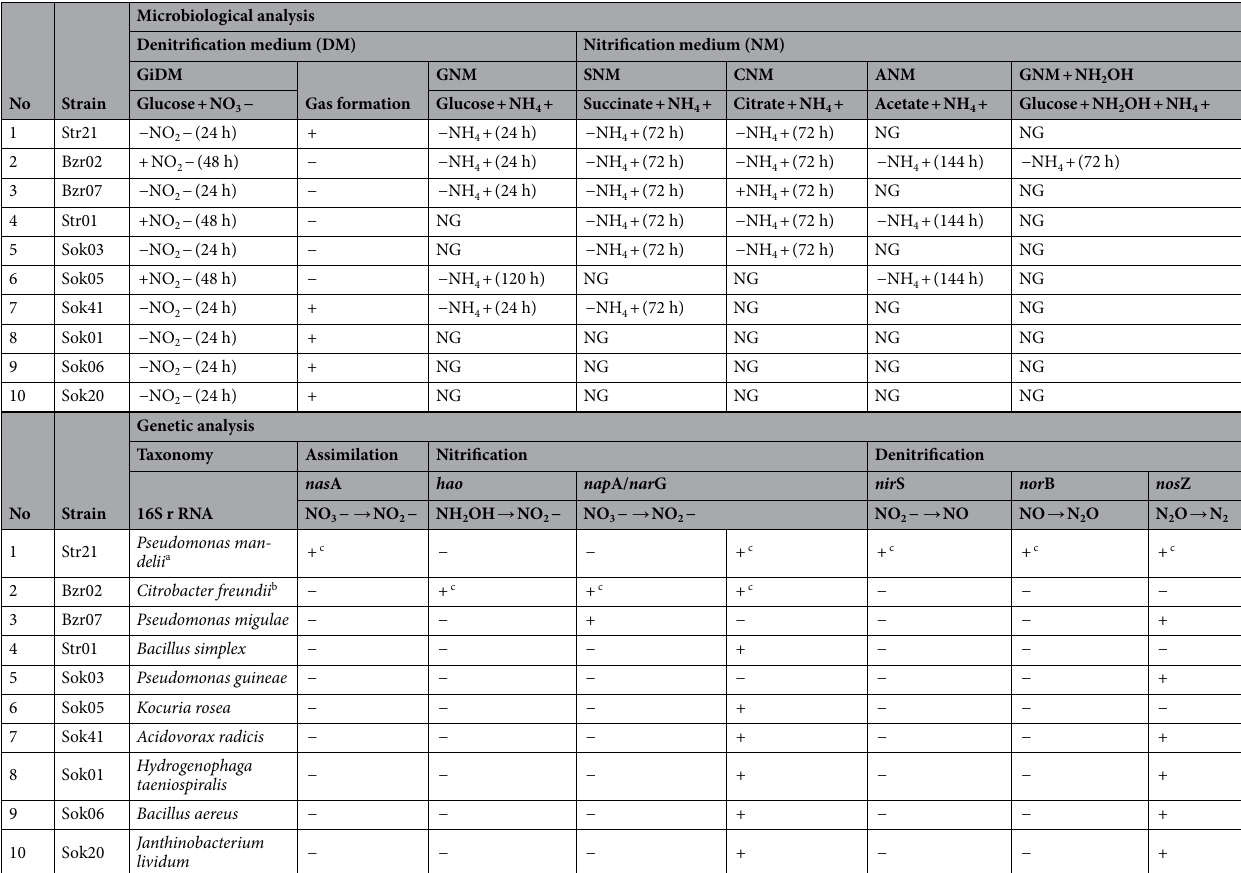
Table 1. Bacterial strains capable of nitrogen transformation in different media. - NO 2 − : no detection or full transformation of nitrite; + NO 2 − : detection or incomplete transformation of nitrite; (#h): incubation hours; + : detection; −: no detection;—NH 4 + : no detection or full transformation of ammonium; + NH 4 + : detection or incomplete transformation of ammonium; NG: no bacterial growth. Taxonomical ID for the strain Str21 a was also confirmed with the sequence analysis of rpo B gene in supplementary Fig S1 , and the Strain Bzr02 b with BIOLOG Gen III plates in supplementary Table S2 . c The nucleotide BLAST similarity analysis for the functional genes detected in strains Str21 and Bzr02 was presented in supplementary Table